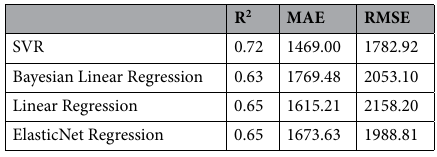
Table 1. SVR Regression results.